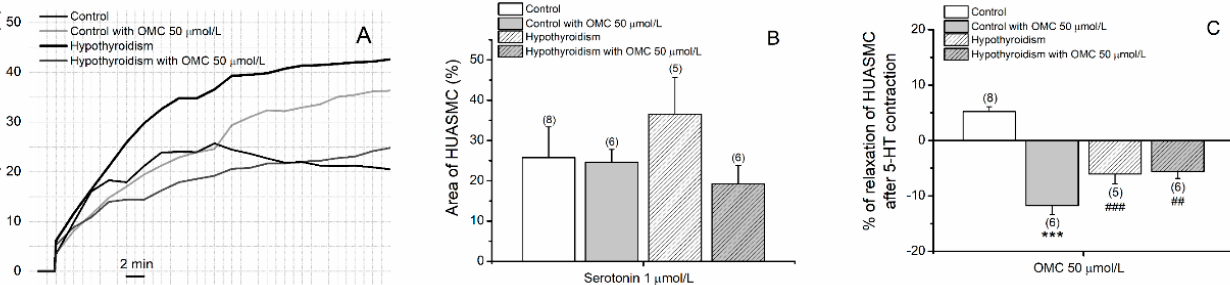
Figure 6. Effects of OMC on the human umbilical artery smooth muscle cells (HUASMCs) without (control) and with hypothyroidism incubated with octylmethoxycinnamate (OMC, 0 and 50 µmol/L) and contracted by serotonin (5-HT; 1 µmol/L). ( A ) Contractile response of HUASMC (%) during 40 min; ( B ) area (%) (at time 20 min) of the HUASMC and ( C ) percentage of relaxation of HUASMC after 5-HT contraction. Each bar represents the mean, vertical lines the S.E.M. and the number within brackets the n . Asterisk * represents a significant difference versus incubation: *** p < 0.001, and Hashtag # represents a significant difference versus hypothyroidism: ## p < 0.01 and ### p < 0.001; two-way ANOVA method followed by Holm–Sidak post-hoc tests.